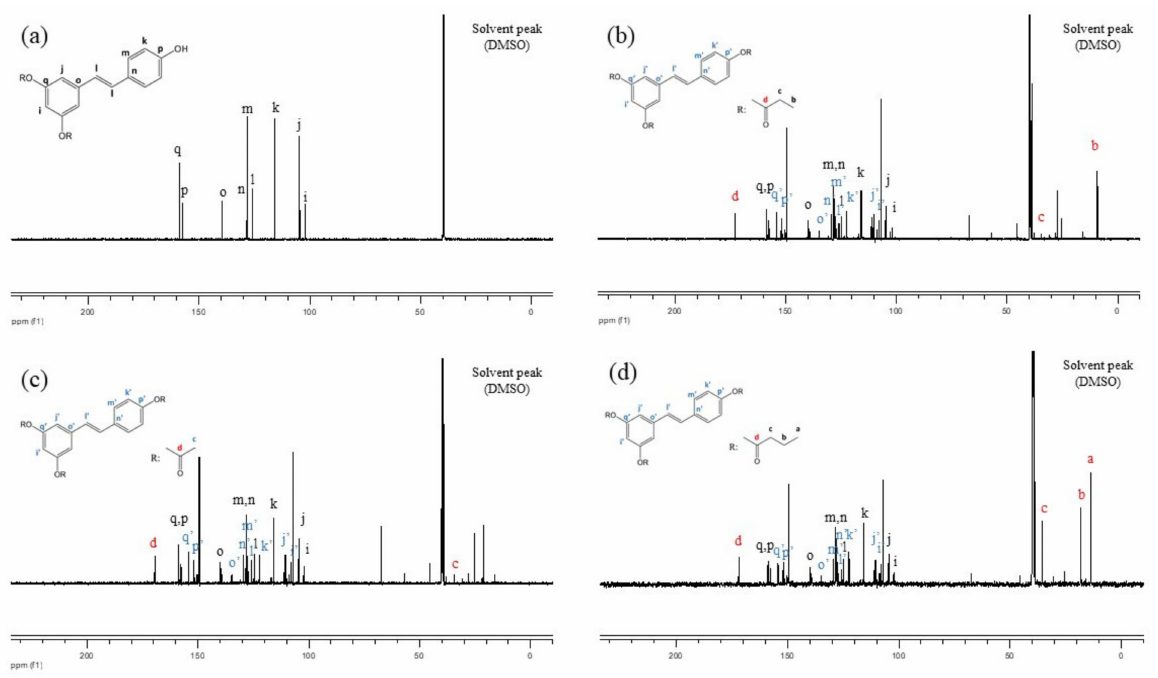
Figure A2. 13 C nuclear magnetic resonance spectra of ( a ) resveratrol, ( b ) resveratrol acetate, ( c ) resveratrol propionate, and ( d ) resveratrol butyrate. Here, DMSO Dimethyl